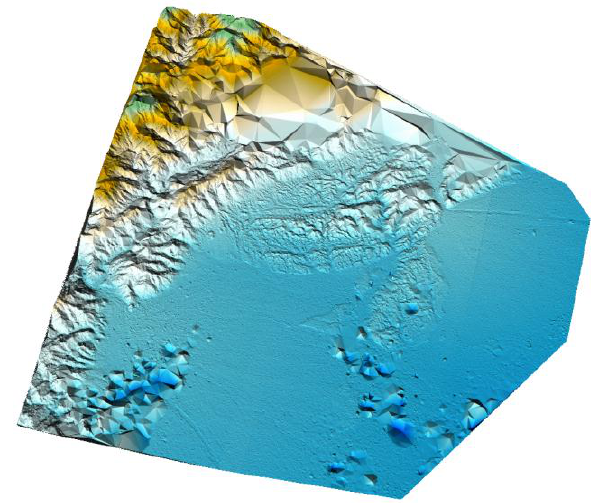
Figure 6. A view of the generated DEM from ALOS stereo imagery over Hongkou, Sichuan, China